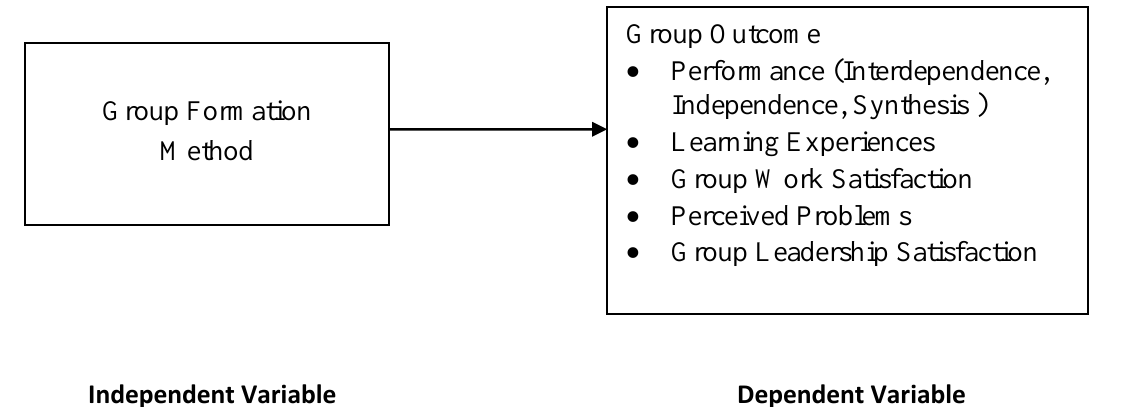
Figure 1 : Relationship between independent and dependent